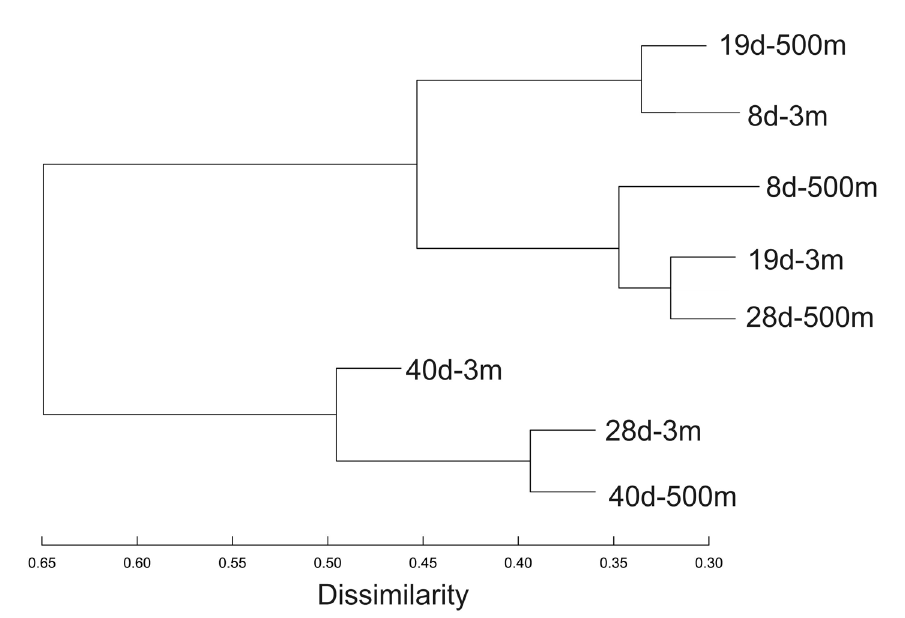
Figure 6. Dendrogram representing the Bray–Curtis similarity between metagenomes obtained from communities sampled after 8 days (8d), 19 days (19d), 28 days (28d) and 40 days (40d) from aquaria inoculated with water from 3 or 500 m